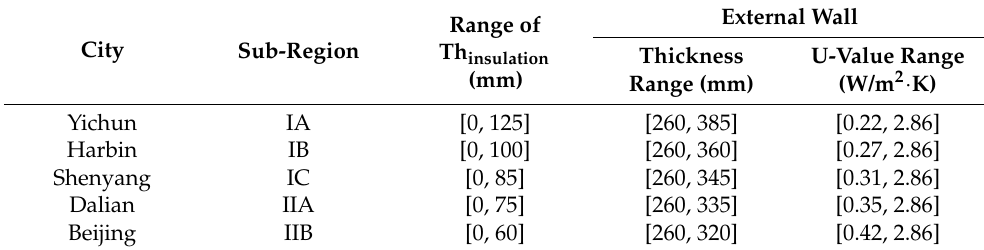
Table 4. Range of Th insulation in each city in the simulation settings.